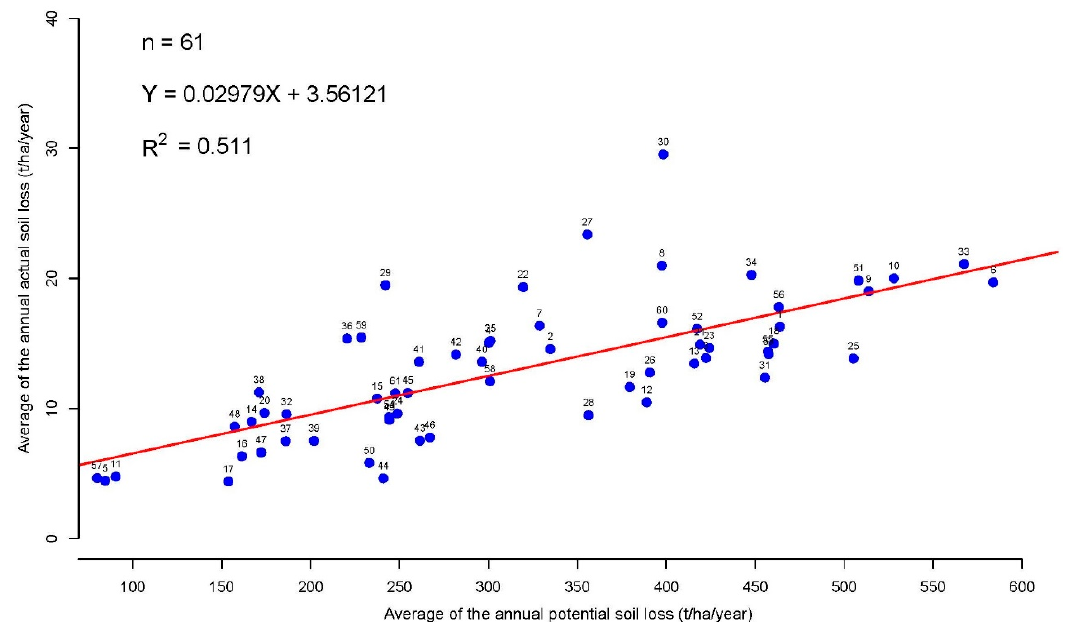
Figure 9. Relationship between average potential soil loss (i.e., R*K*LS product) and the actual soil loss (R*K*LS*P*C) in the KhRB, in individual subbasins.